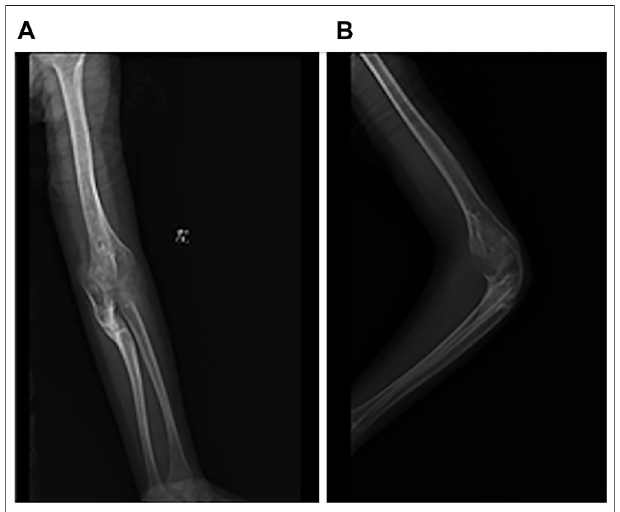
FIGURE 2 | Radiograph of left elbow joint from conservative treatment. (A) AP view of elbow joint. (B) Latereal view of elbow joint.